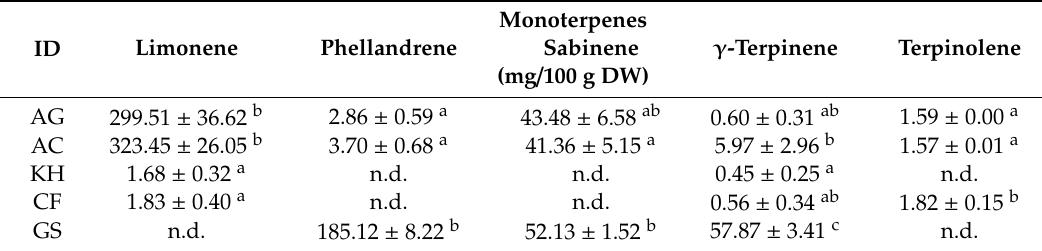
Table 3. Monoterpenes in analysed dried